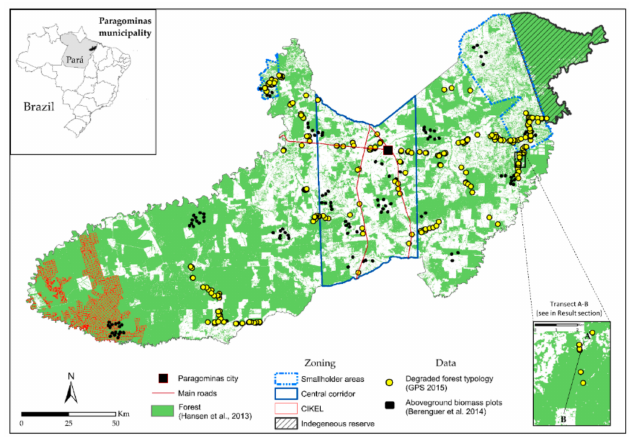
Figure 1. Map of Paragominas municipality in the northeastern part of the State of Para with the location of the biomass-collected plots, the degraded forest typology and the main zoning areas (extracted from